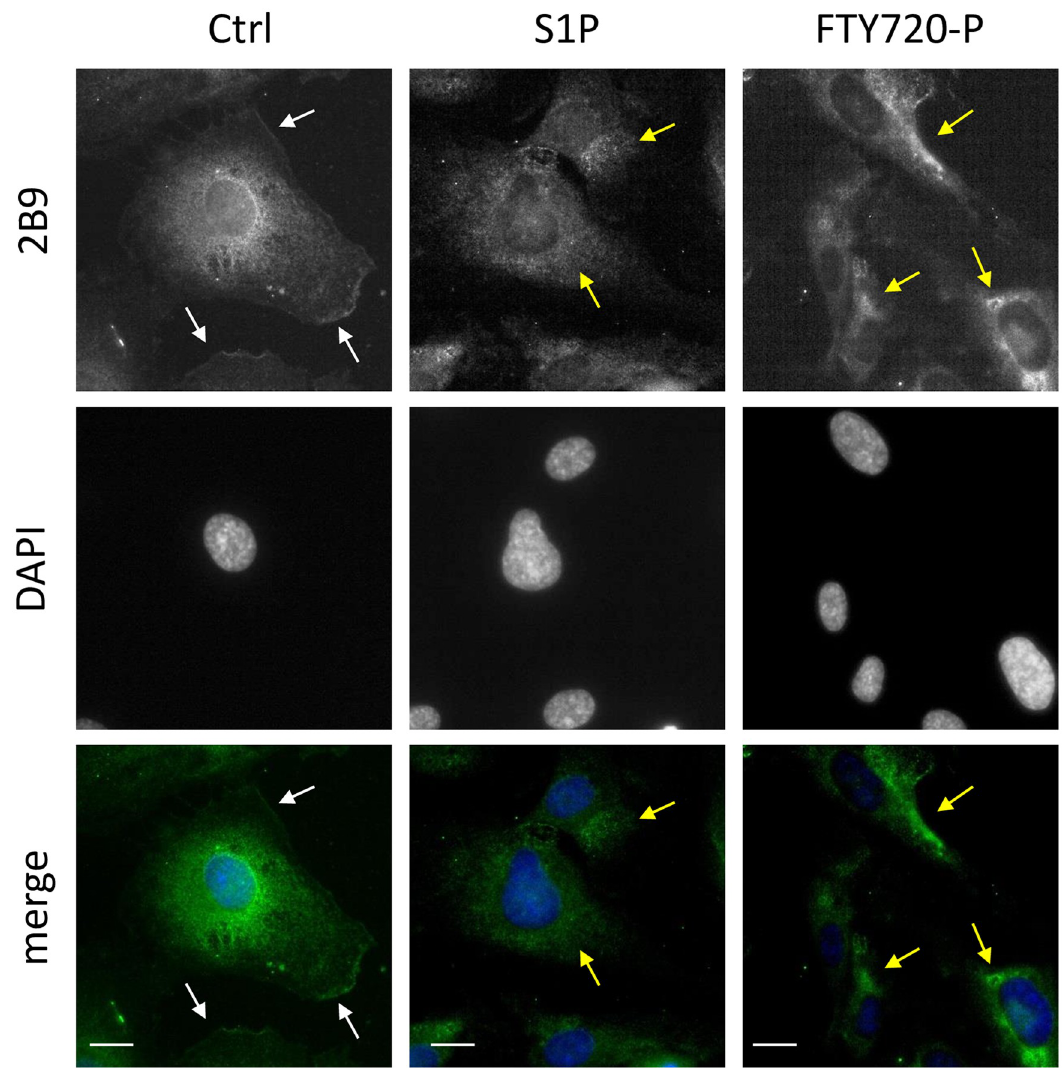
Fig 9. Endogenous S1P 1 agonist-induced internalization can be followed with 2B9. HUVEC cells were seeded on coverslips and 24h later were serum starved for 2 hours. Cells were then stimulated with either vehicle (Ctrl), S1P (1 μ M) or FTY720-P (1 μ M) for 30 min, then fixed, permeabilized and stained with 2B9 (1:100, w/v, green) and DAPI (blue). Under serum starvation conditions (Ctrl)